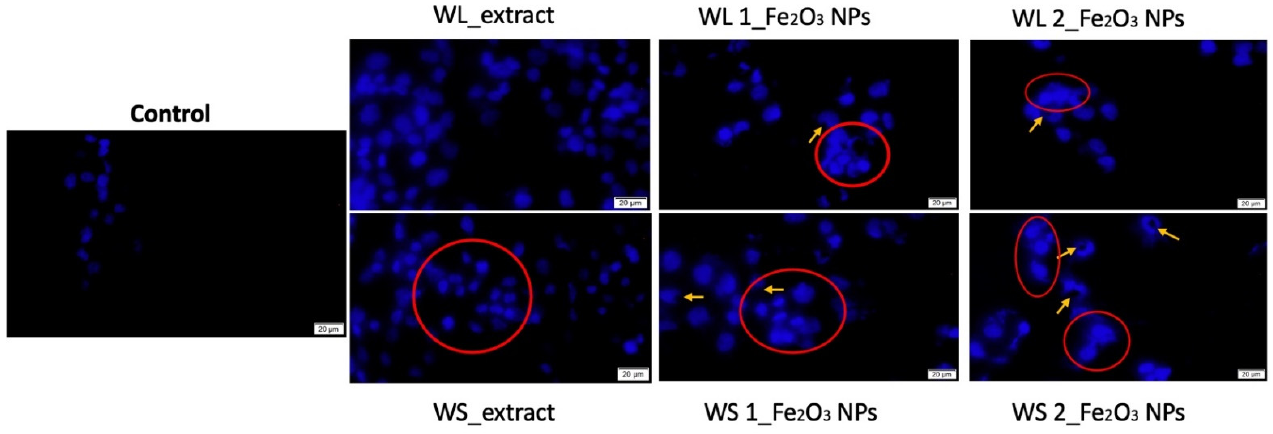
Figure 15. Morphological aspects of human melanoma cells–A375 nuclei treated with concentration of 500 µg/mL wormwood leaves (WL) and wormwood stems (WS) extracts and different Fe 2 O 3 NPs obtained from these extracts (WL 1_Fe 2 O 3 NPs; WL 2_Fe 2 O 3 NPs, respectively WS 1_Fe 2 O 3 NPs; WS 2_Fe 2 O 3 NPs) for an interval of 72h. The scale bars represent 20 µm. Fe 2 O 3 NPs that are either attached or embedded in the cells nuclei are marked with yellow arrows, while the red circles highlight the apoptotic markers.